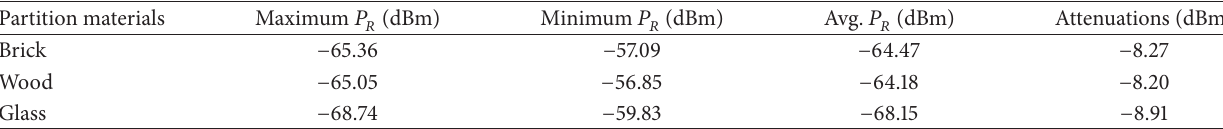
Table 4: Obtained minimum, maximum, average, and deviations of received power when a human body moves along a predefined path within the given